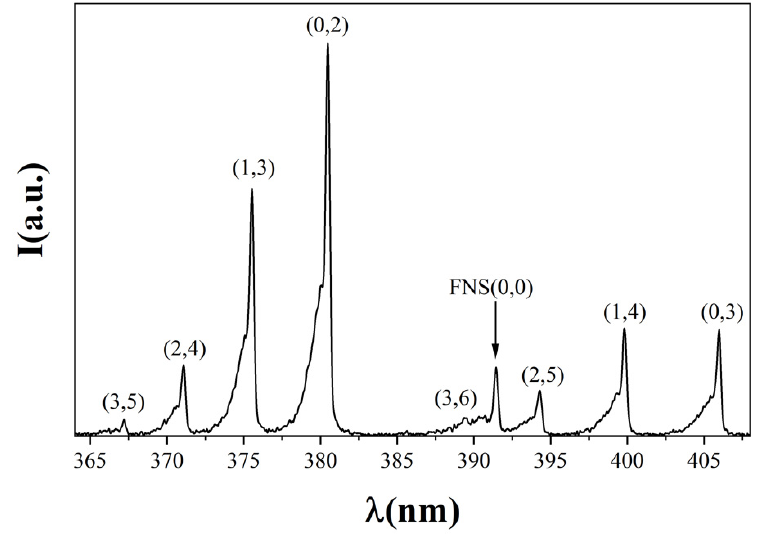
Figure 5. Emission spectra of SPS .